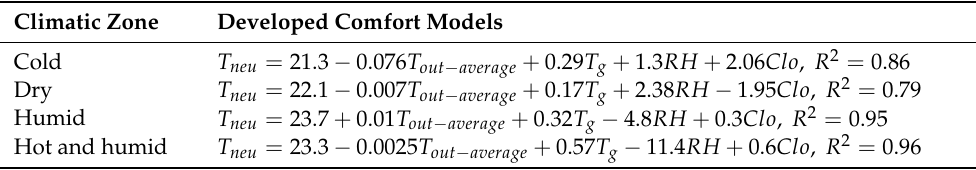
Table 3. Developed comfort models for different climatic zones [106].